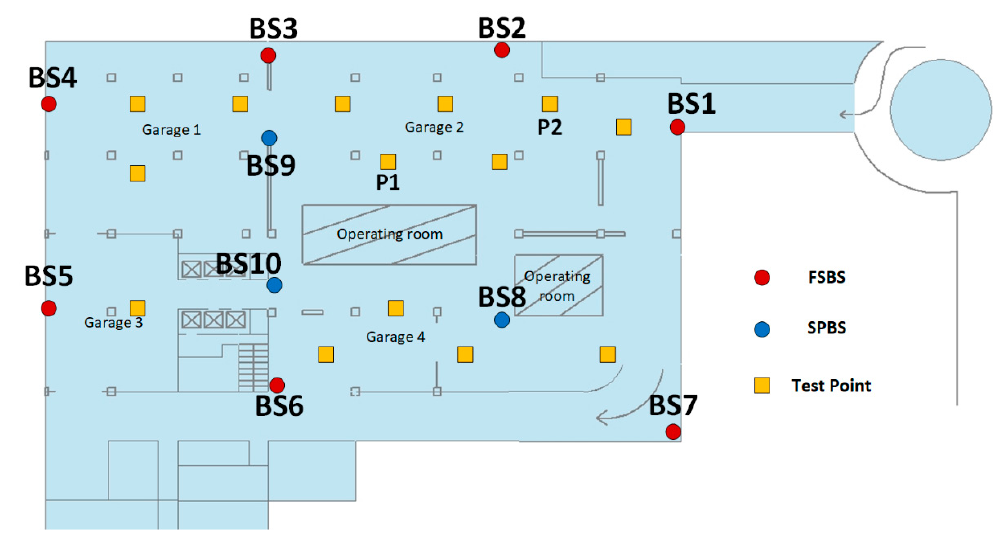
Figure 16. Plan of the test field.